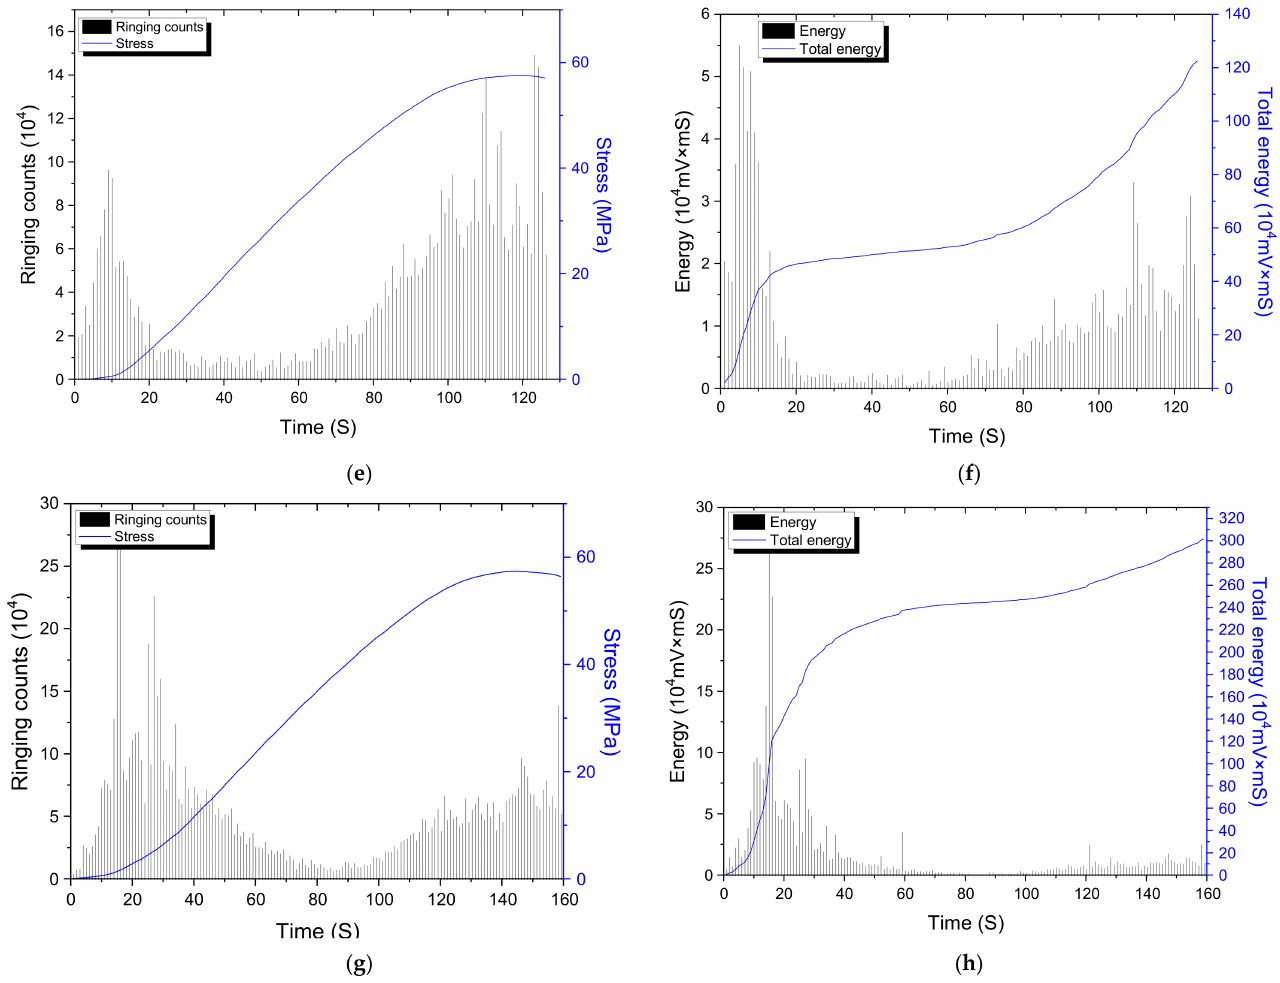
Figure 6. Counts, stress, and energy in terms of loading time of A-80% concrete samples of different pre-loading stages. ( a ) A-3-80% counts and stress development. ( b ) A-3-80% energy development. ( c ) A-7-80% counts and stress development. ( d ) A-7-80% energy development. ( e ) A-14-80% counts and stress development. ( f ) A-14-80% energy development. ( g ) A-28-80% counts and stress develop- ment. ( h ) A-28-80% energy development.